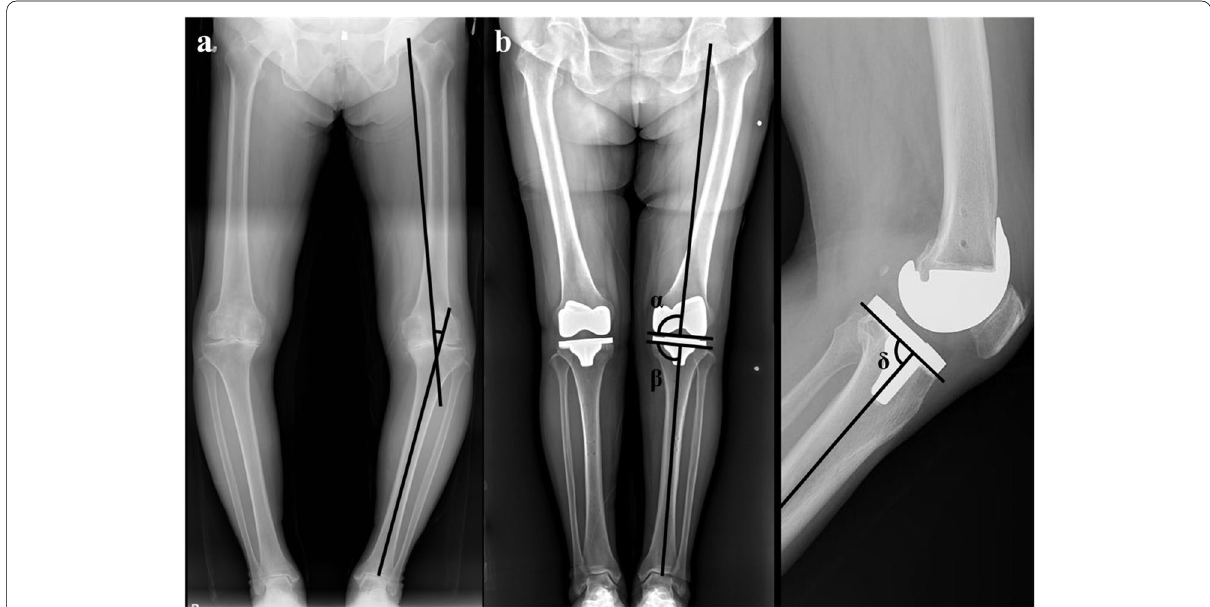
Fig. 1 a The mechanical axis of the leg is the angle formed between the mechanical axis of the femur and tibia. b Radiologic measurement of femoral and tibial implants. α: coronal inclination of the femoral component with the mechanical axis of the femur, β: coronal inclination of the tibial component with the mechanical axis of the tibia, δ: sagittal inclination of the tibial component with the mechanical axis of the